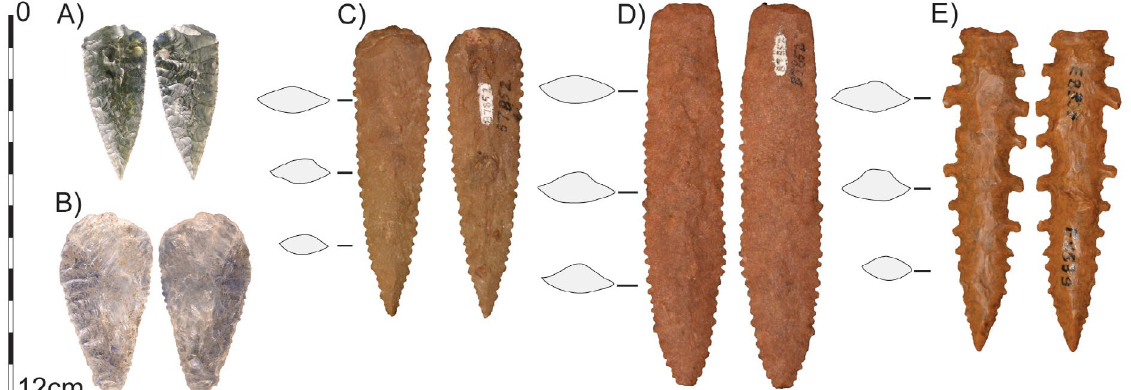
Figure 1. Pressure flaked bifaces (a.k.a. Kimberley Points). A) Bottle glass Kimberley Point with serrate margins from Historical period (McSherry’s Gap Figure 2) B) Crystal quartz Kimberley Point with serrate margins (Mt Behn Figure 2) C) Quartzite Kimberley Point with serrate margins (3D model available as object file) D) Quartzite Kimberley Point with serrate margins E) Chert Dentate Kimberley Point with dentate and serrate margins (collected near Wolf Creek Figure 2). The scale bar is 12cm long divided into 1cm